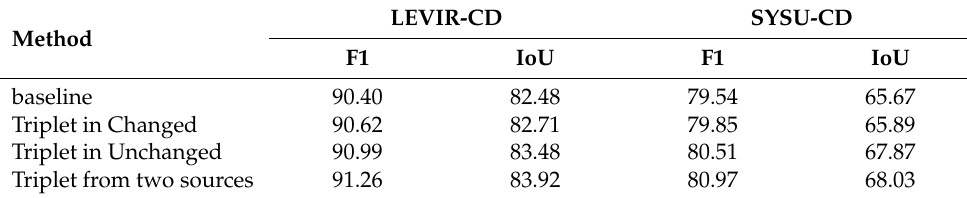
Table 4. The accuracy on the two sources of triplet